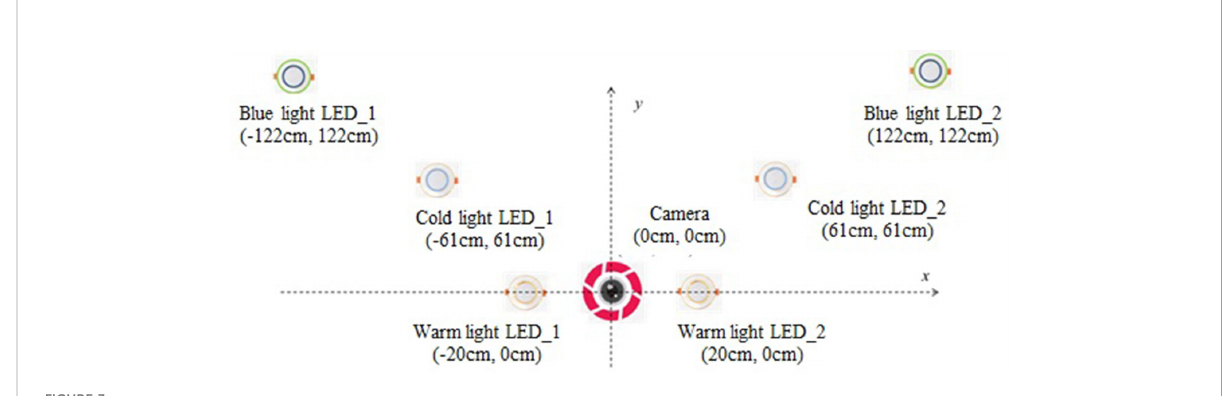
FIGURE 3 The schematic diagram of deep-sea lighting system